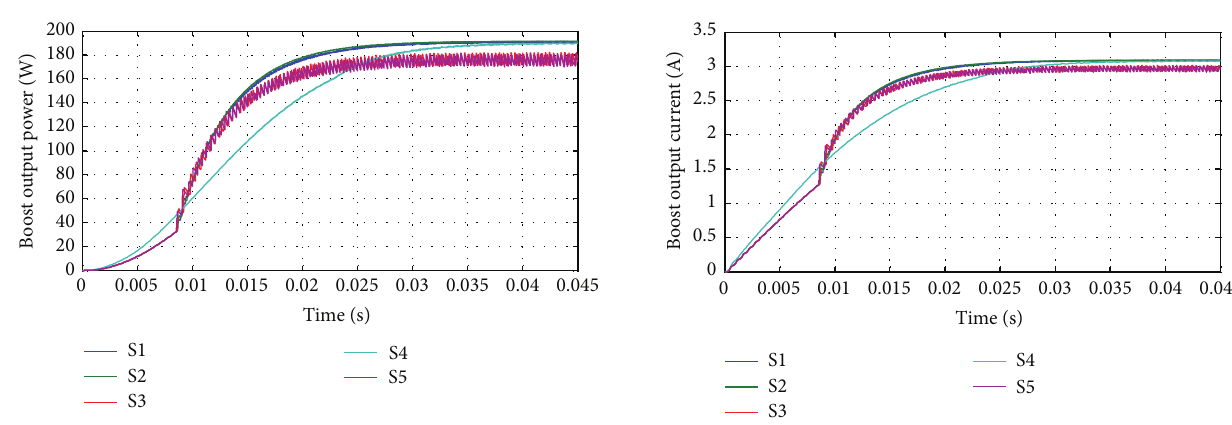
Figure 19: Boost output current at irradiation of 1000 W/m 2 and 25 ∘ C.